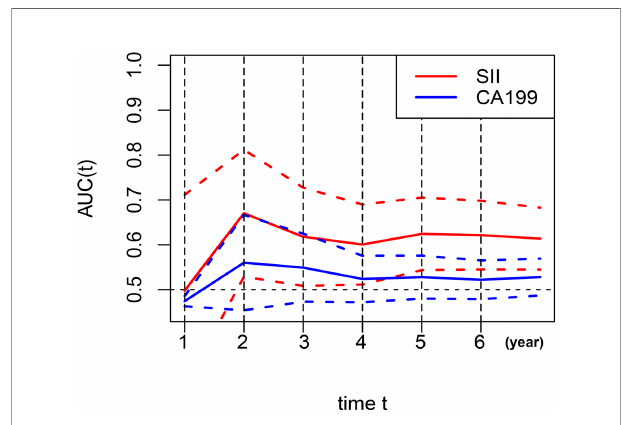
FIGURE 6 | Dynamic change for predictive abilities of SII and CA19-9 during the observation period. SII, systemic immune-in fl ammation index; CA19-9, carbohydrate associated antigen